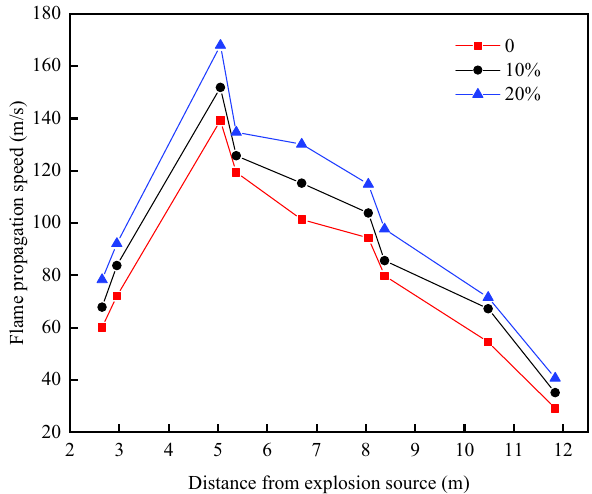
Figure 8. The maximum flame propagation velocity of the O–A–D–E–H–G